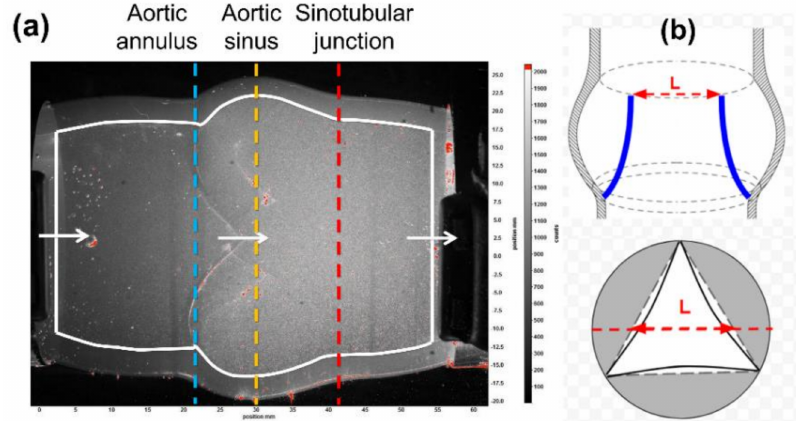
Figure 3. Example raw image of the aortic root demonstrating ( a ) three major sites (aortic annulus, sinus, and sinotubular junction) for deformation analysis and ( b ) the effective length of the orifice ( L ).